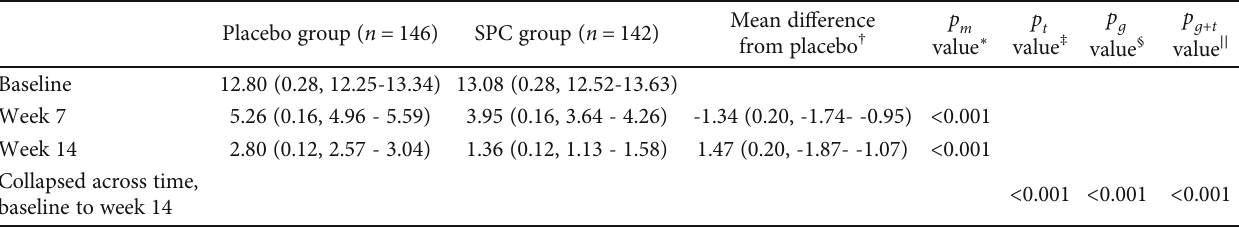
Table 2: Primary outcomes for research worker-rated HADAS